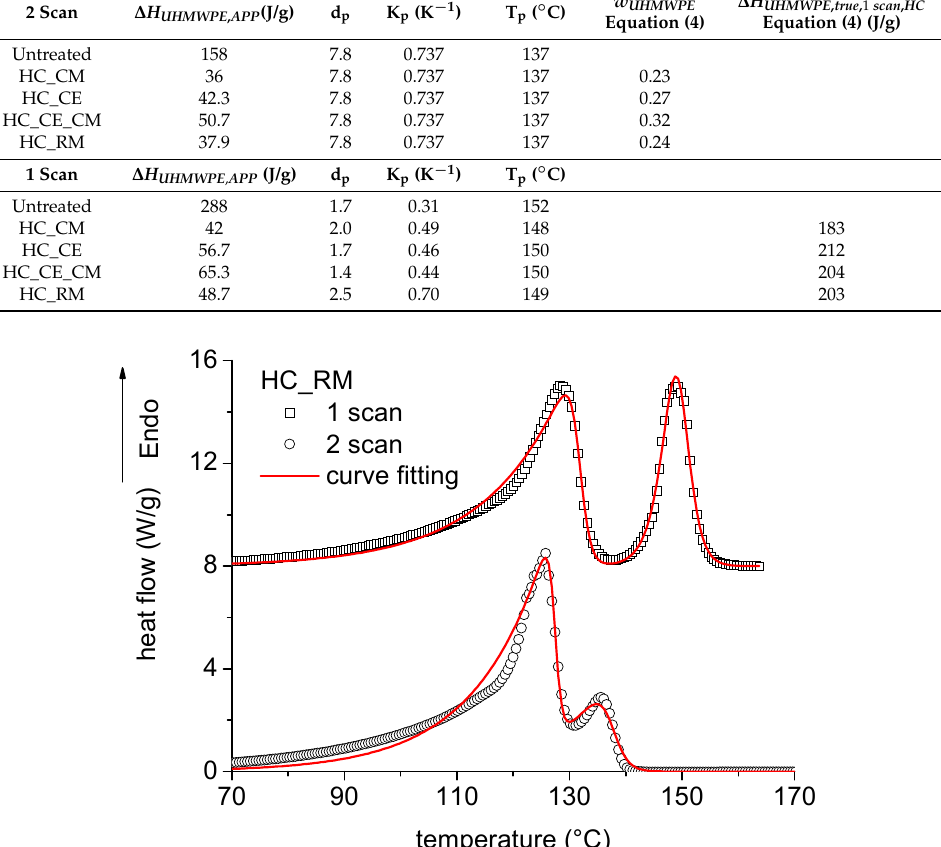
Figure 5. DSC curves on rotational molded samples and nonlinear curve fitting according to Equation (6).